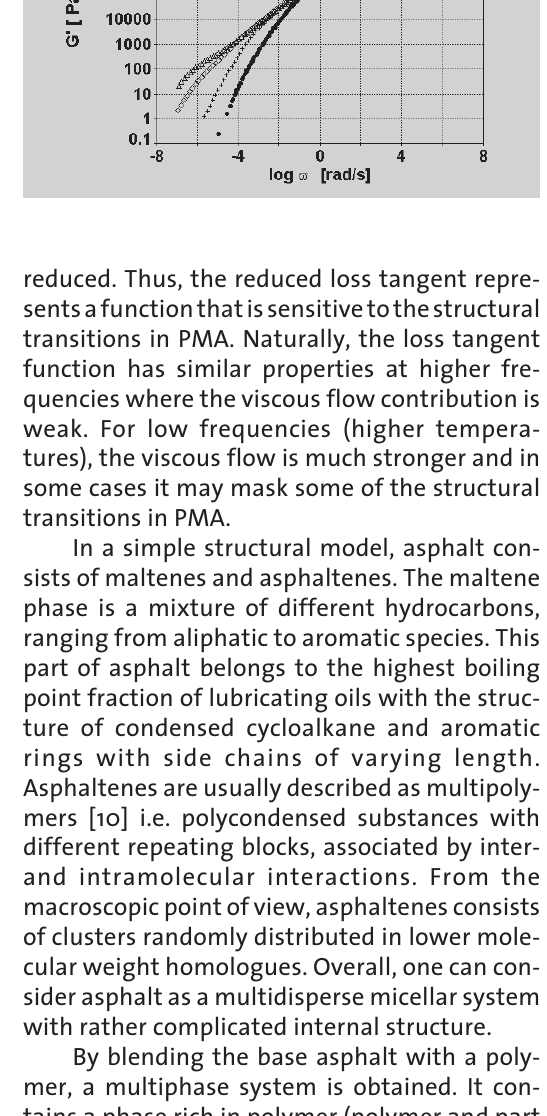
Figure 1 (bottom): Schematic picture of asphalt microstructure. Figure 2 (left): Horizontal shift factor. Base asphalt and all investigated blends